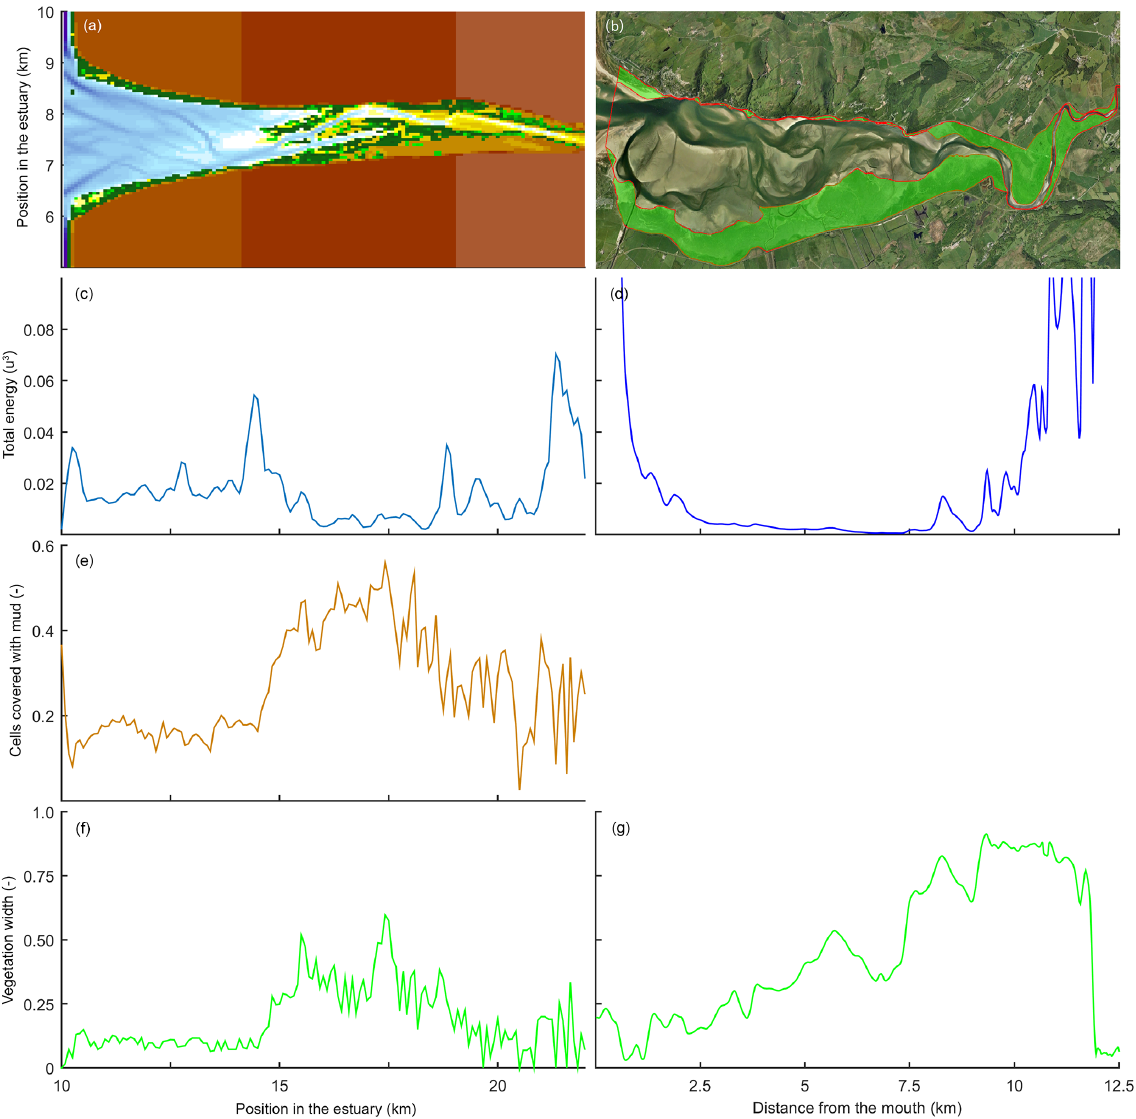
Figure 13. Comparison of mudflats and tidal marsh vegetation in a modelled (left) and natural (right) system. Here, velocity magnitude to the power of 3 is plotted as an indication for hydrodynamic energy. Panels (a) and (b) show the estuary bathymetry and vegetation, (c) and (d) show the total energy along the estuary, (e) shows the mud covered area along the estuary, and (f) and (g) show the relative vegetated width of the